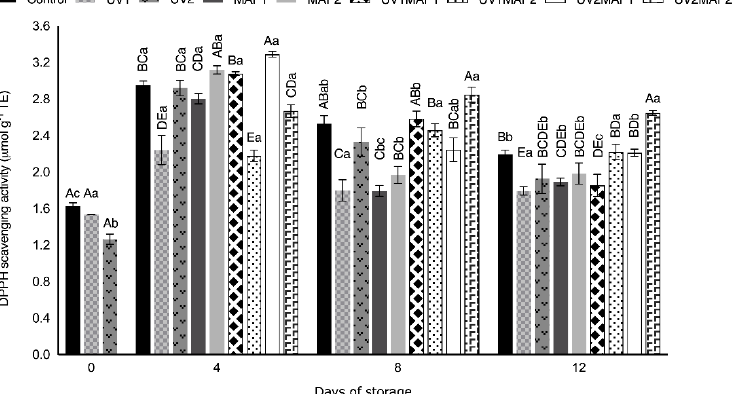
Figure 8. Antioxidant capacity to inhibit 1,1-diphenil-2-picrilhidrazil (DPPH) free radical of raspberries stored in air (control), treated with UV-C radiation (UV1 or UV2), packaged in MAP (MAP1 or MAP2) and their combinations during 12 d of storage. Values represent mean ± standard deviation ( n = 3). Lower case letters indicate significant differences ( p < 0.05) among days within the same batch. Capital letters indicate significant differences ( p < 0.05) among batches within the same day.